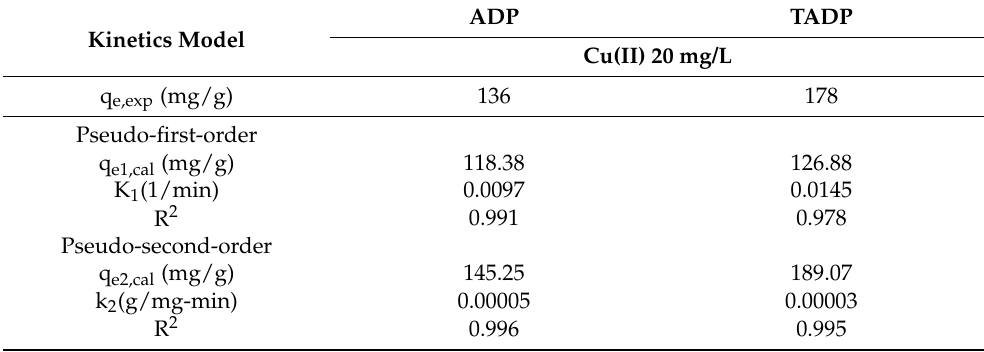
Table 3. Kinetic parameters calculated for the adsorption of Cu(II) on ADP and TADP adsorbents (initial concentration, C 0 for Cu(II) was 20